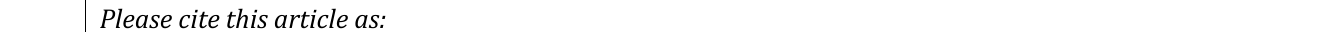
Temporary migration; domestic violence; border